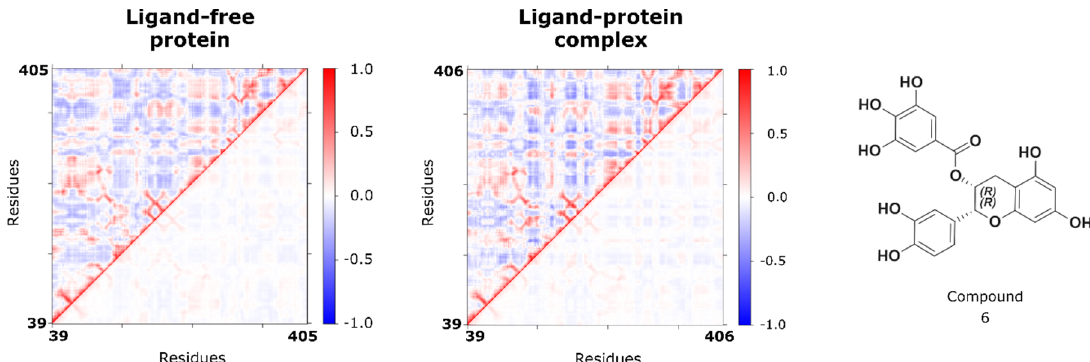
Figure 7. Molecular recognition of compound 6 and human topo II α ATP binding site (PDB: 1ZXM). ( A ) Two alternative conformations of compound 6 in the ATP binding site identified by molecular docking. ( B ) Molecular simulation of the topo II α : compound 6 complex. ( Right ) A snapshot from the MD simulation showing measured distances between compound 6 and surrounding residues. ( Left ) A complex interplay of OH groups that can interact interchangeably with Asn120. ( C ) Calculated cross-correlation matrices of the ligand-free and ligand 6-bound topo II α systems. Residue 406 designation in the second matrix marks compound 6.